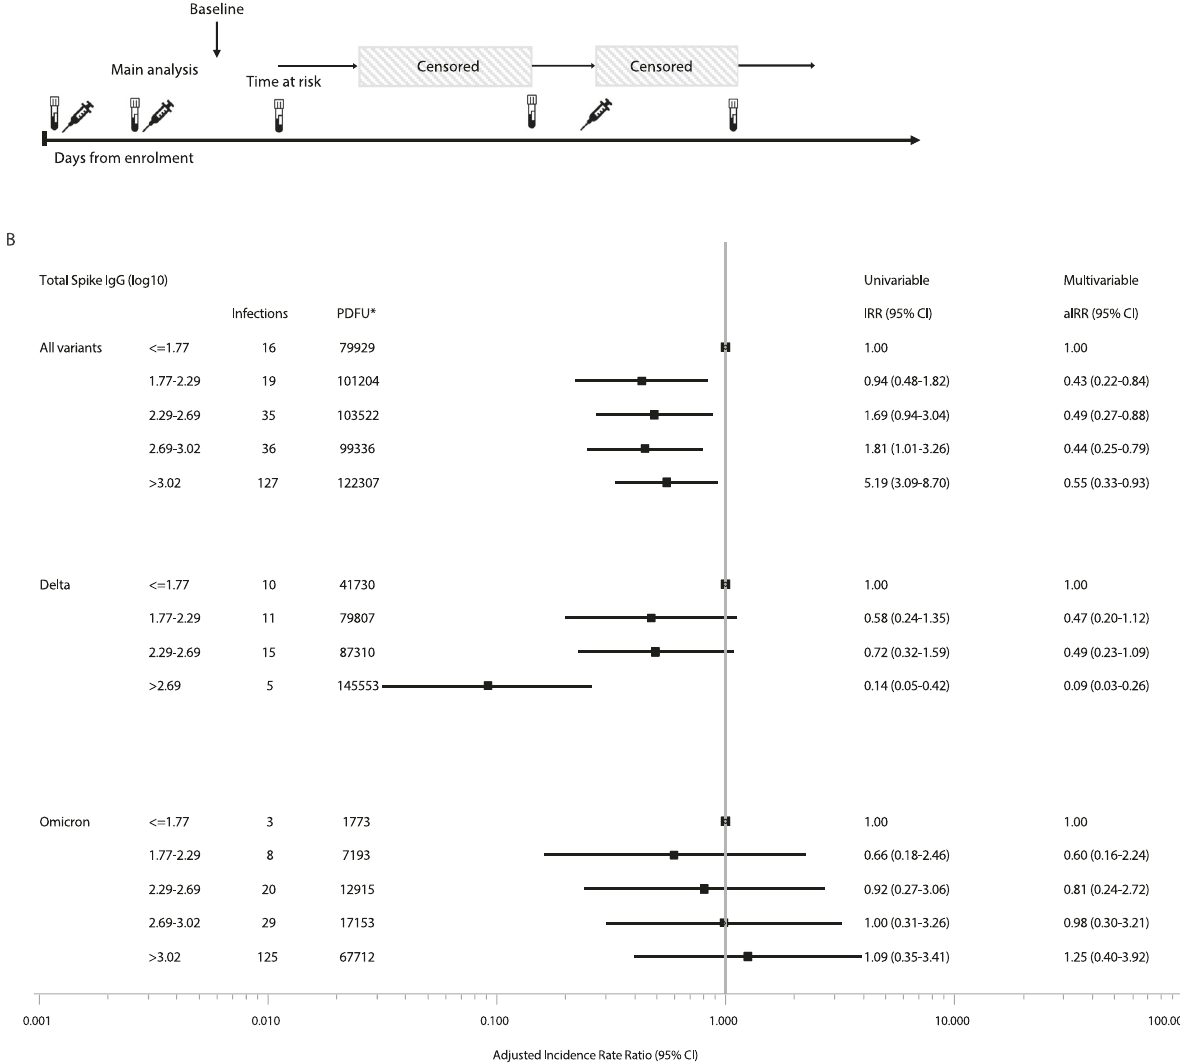
enrolment(peryearlater),gender(malevsfemale),beinghealthcareworker(novs yes)andtransmissionlevelwithtwo-sidedchi-squaredtestsforeachvariableinthe model. The multivariable model for the Omicron variant did not include trans- mission level as all infections occurred during the very high transmission period. ThemultivariablemodelfortheDeltavariantdid notincludehealthcareworker,as there were no delta infections in this group in the sensitivity analysis. All variants analysis: n =6073, Delta analysis: n =6034, Omicron analysis: n =4388. The forest plotpresentstheaIRRand95%con fi denceintervalsfromthemultivariablemodels. *Person days of